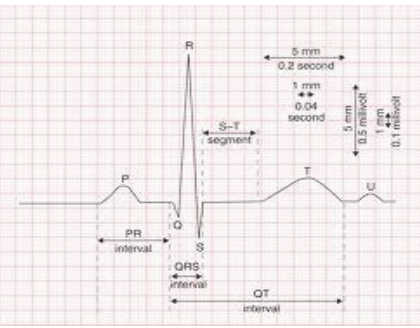
Figure 4: (Umbilical artery Doppler. Good EDF, PI 0.83).